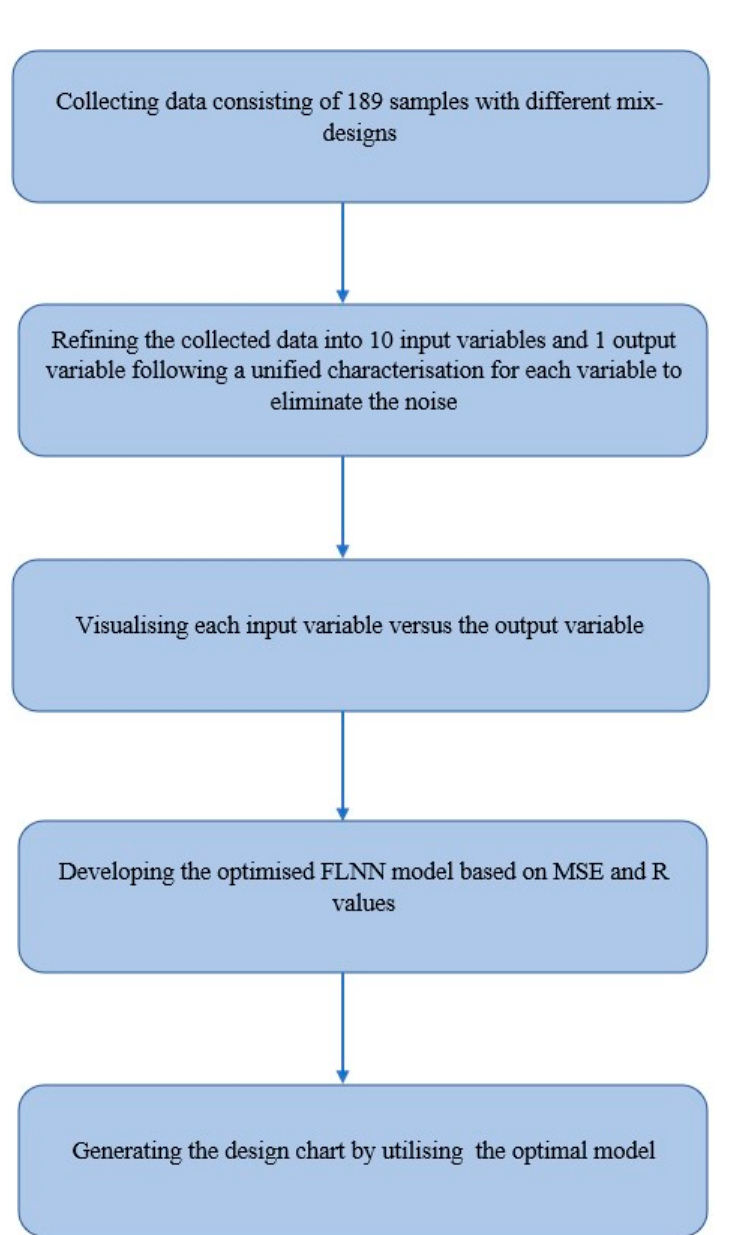
Figure 1. Graphical outline of the study design.